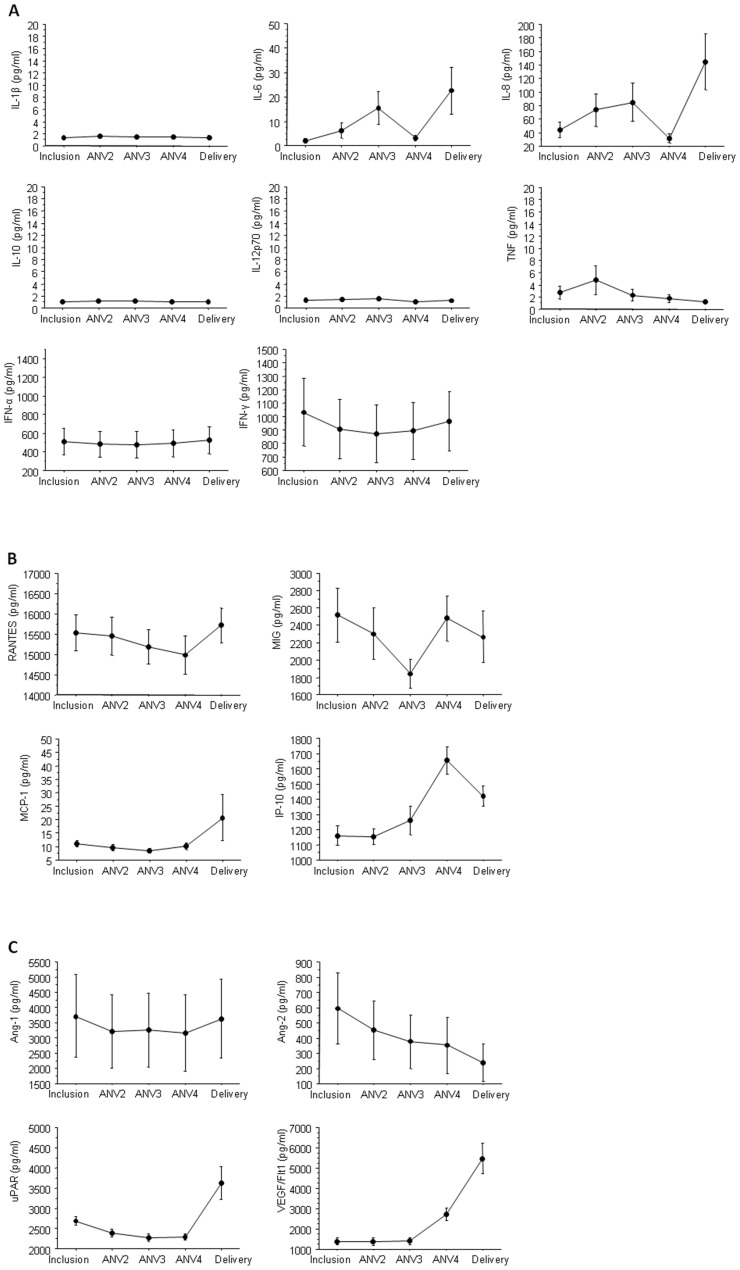
Baseline plasma levels of several inflammatory factors and others throughout pregnancies not complicated by malaria.Plasma levels of (A) cytokines, (B) chemokines, and (C) angiogenic factors in plasma samples from 79 uninfected pregnant women measured throughout their pregnancy. Samples were analyzed at inclusion, at antenatal visit (ANV) 2, 3 and 4 and at delivery by ELISA or CBA. The dots represents the mean value and the bars the standard deviation.